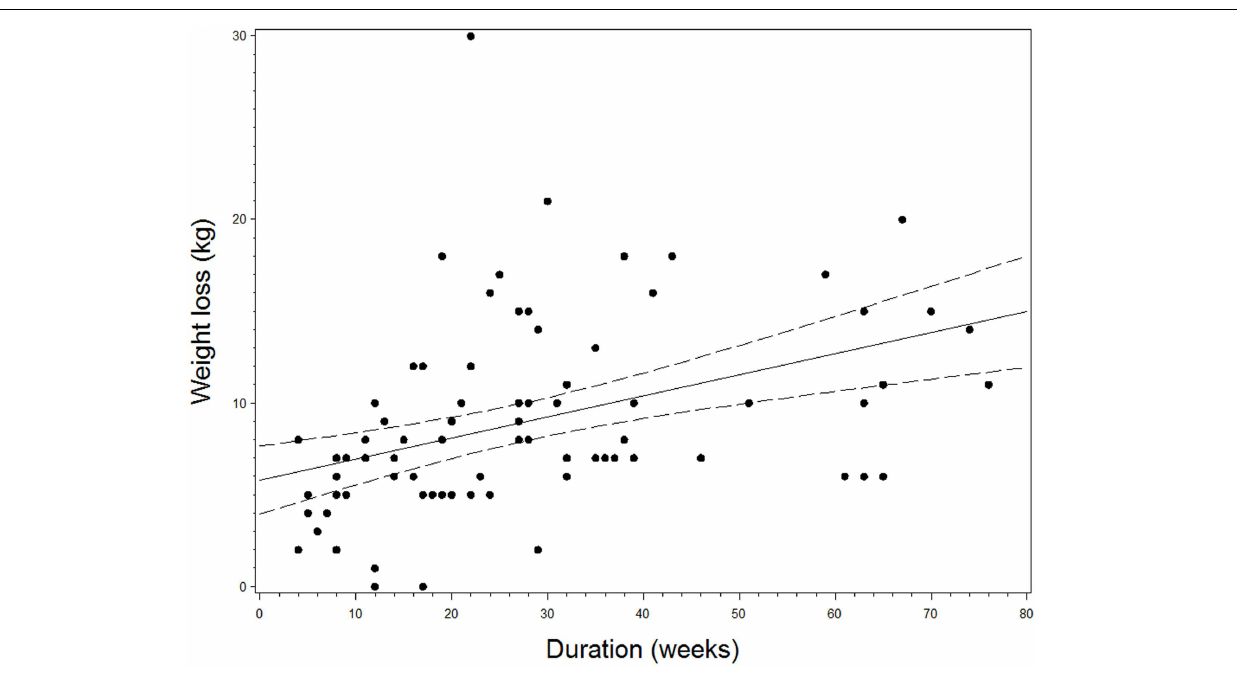
lost to follow after more than 4 weeks of treatment. These women were included in the analysis with data from their last clinical